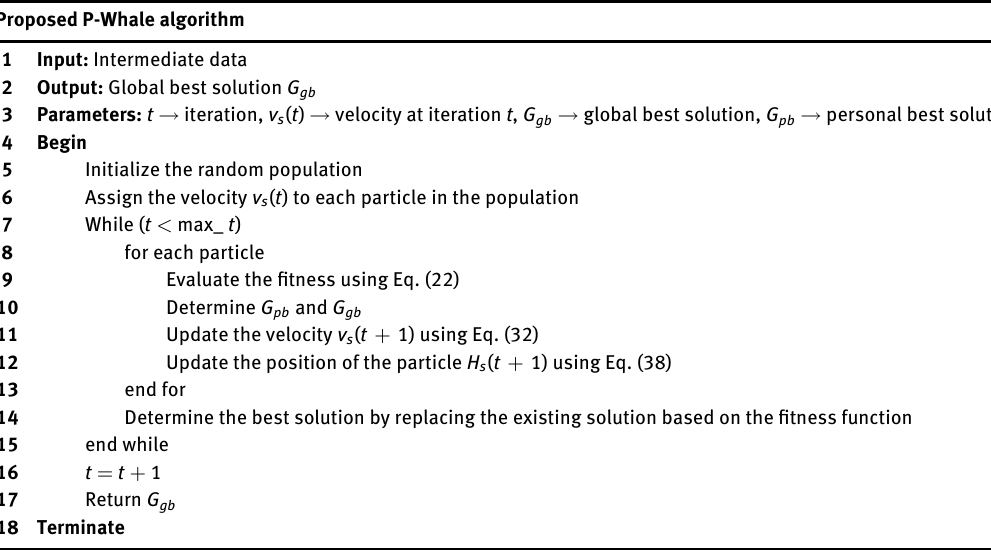
Table 1: Pseudocode of the P-Whale Algorithm. Proposed P-Whale